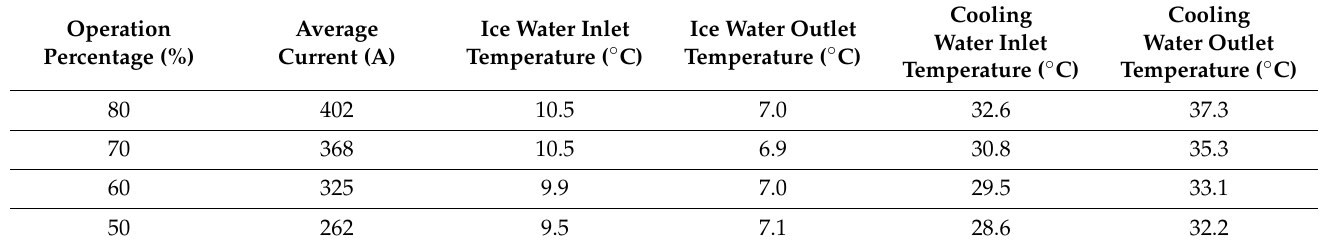
Table 5. Actual water chiller operation value on